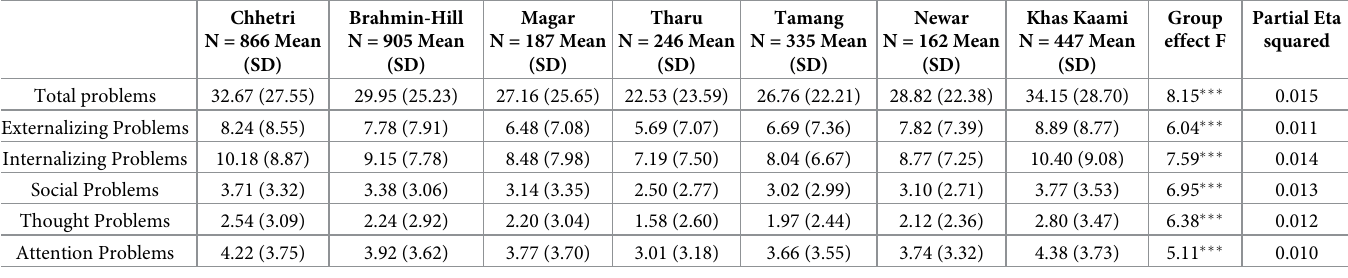
Table 5. The magnitude of EBP in the different castes and ethnic